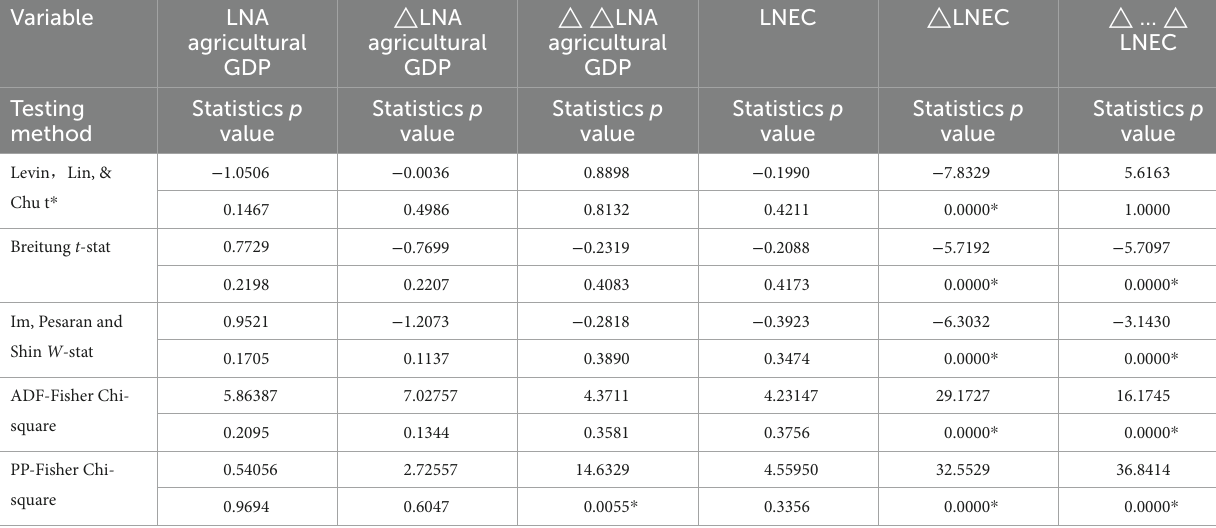
TABLE 3 Unit root test results of each variable in Class III blocks.